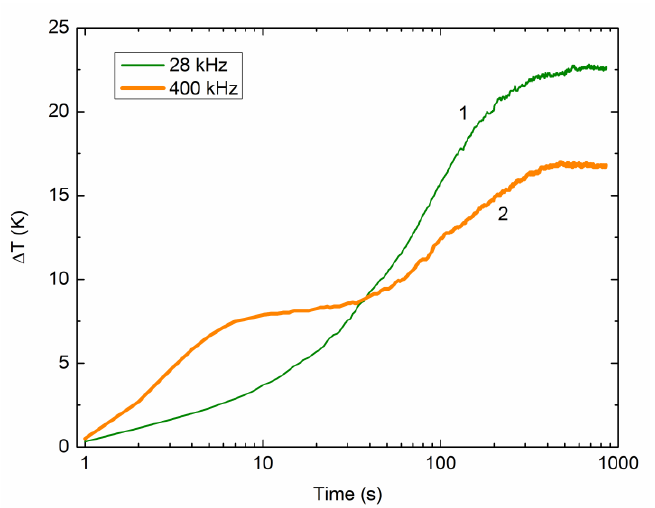
Figure 5. Variation of solution temperature with time after the sonication at 28 (curve 1) and 400 (2) kHz is turned on.